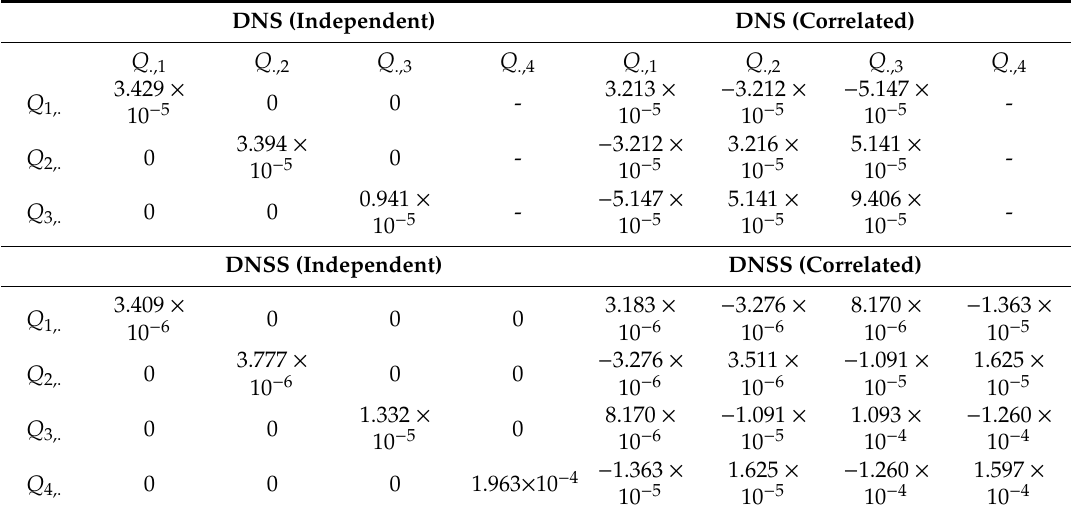
Table 3. The variance–covariance matrix Q of the DNS and DNSS models. DNS (Independent) DNS (Correlated) Q